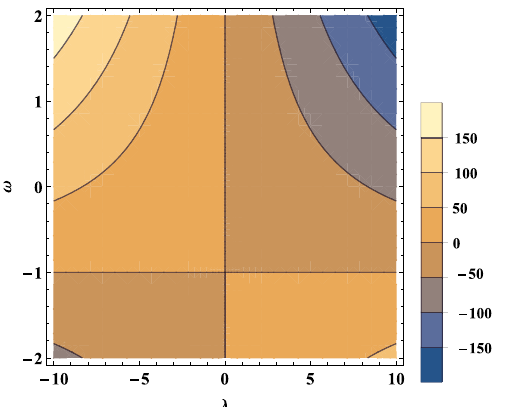
Fig. 1 The 2-dimensional contour plot for the eigenvalues σ 2 (λ,ω) of the Jacobian matrix J ij . The being of σ 2 < 0 regions represent the stability of the